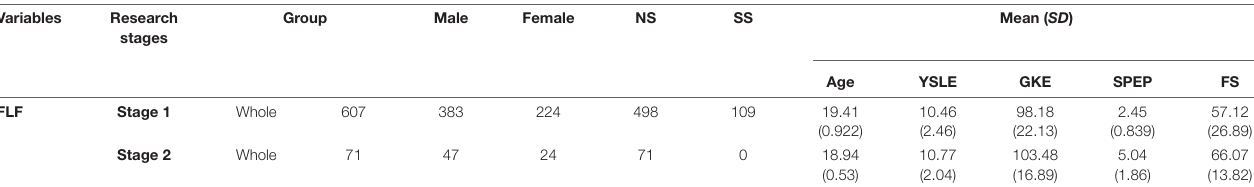
TABLE 1 | Detailed participant information.